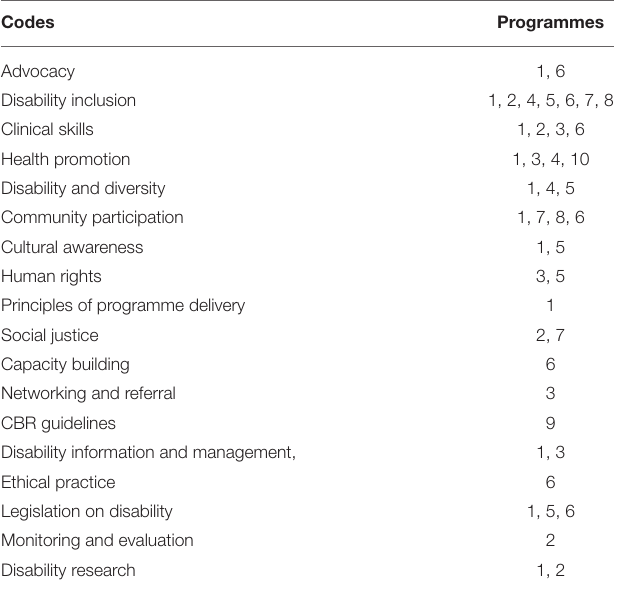
TABLE 3 | Themes emanating from Programmes’ outcomes.